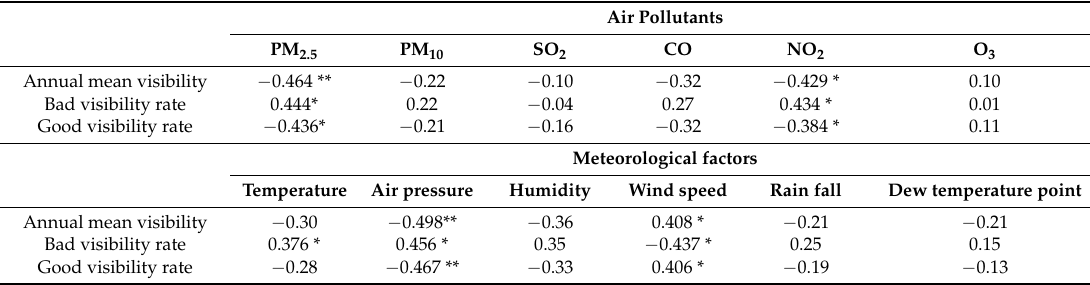
Table 5. Correlation between atmospheric visibility and air pollutants and meteorological factors of 31 PCCs of China, 2016. Air Pollutants PM 2.5